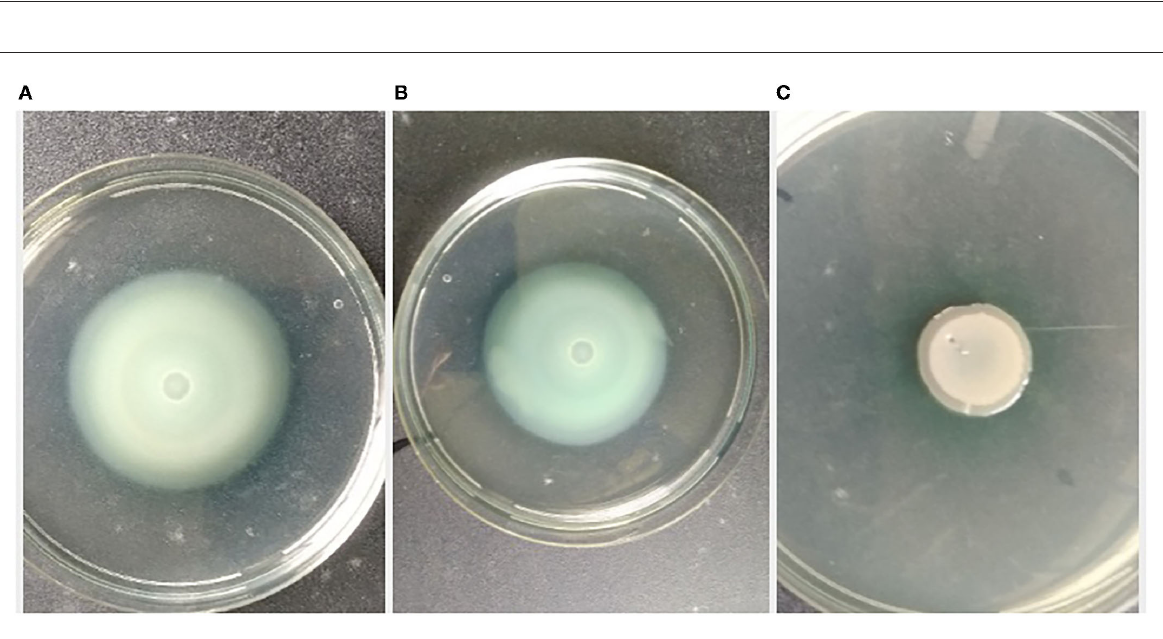
FIGURE5 Effect of crude extract on swimming motility of P. aeruginosa MTCC2297; (A) P. aeruginosa 2,297 alone, (B) P. aeruginosa 2,297 + DMSO (Control), and (C) Ethyl acetate extract of RB isolates (100 µ